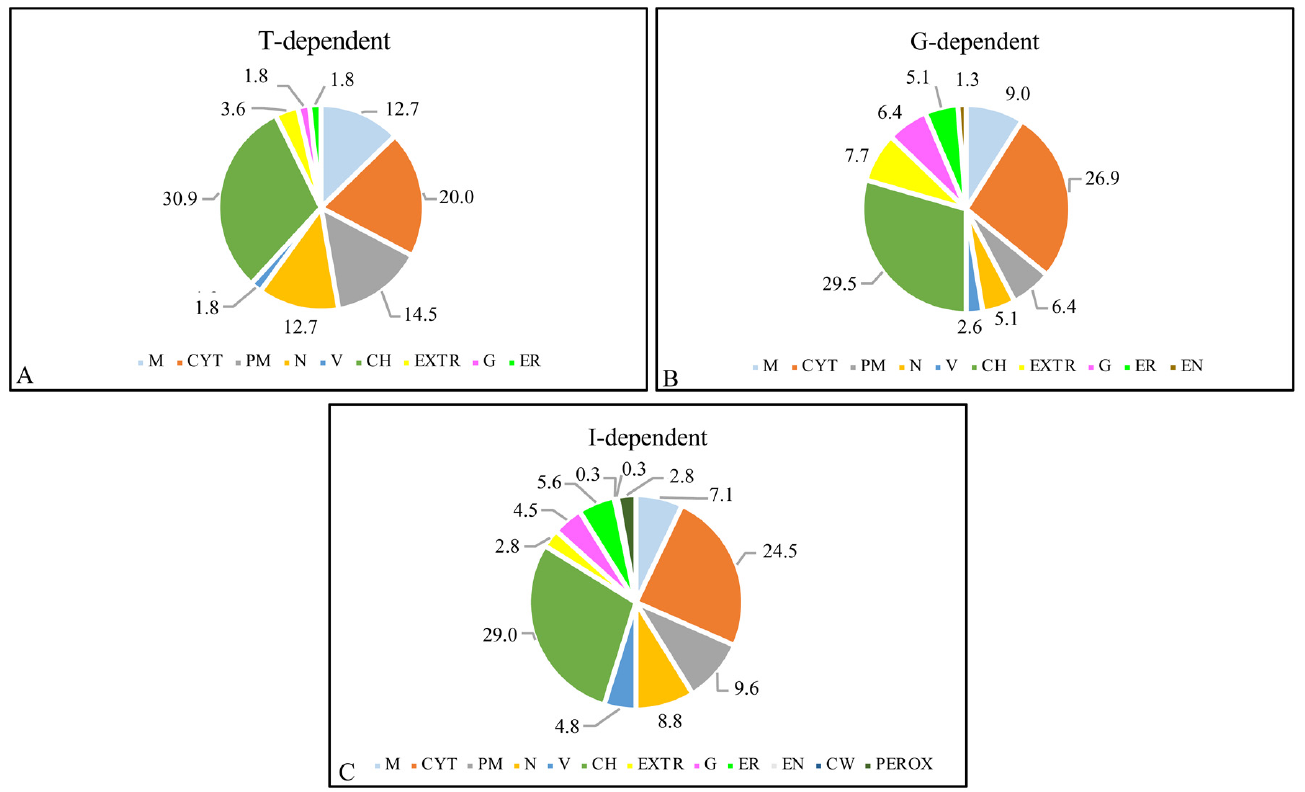
Figure 4. Subcellular localization of ( A ) treatment-dependent DAPs (T); ( B ) genotype-dependent DAPs (G); ( C ) Interaction-dependent DAPs (I), using the multiple marker abundance profiling method of the SUBA4 bioinformatic platform. Abbreviations: M, mitochondria; CYT, cytoplasm; PM, plasma membrane; N, nucleus; V, vacuole; CH, chloroplast; EXTR, extracellular region; G, golgi; ER, endoplasmic reticulum; EN, endosome; CW, cell wall; PEROX, peroxisome. Numbers in the pie charts represent percentages of DAPs belonging to each subcellular compartment with respect to total